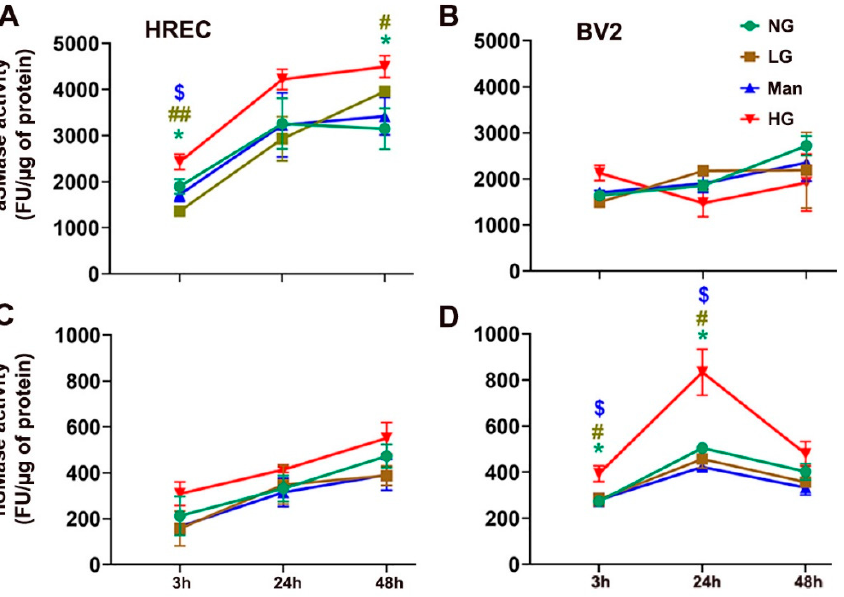
Figure 8. Analysis of SMase enzymatic activity (fluorescence unit/µg of protein) in HREC and BV2 cells cultured in normal glucose (NG), NG + L-glucose (LG), NG + mannitol (Man), and high-glucose (HG) conditions for 3, 24, or 48 h. ( A ) aSMase and ( C ) nSMase activity in HREC. ( B ) aSMase and ( D ) nSMase activity in BV2 cells. * p < 0.05 LG vs. HG; # p < 0.05, ## p < 0.01 Man vs. HG; $ p < 0.05 NG vs. HG; mean ± SEM; n = 3.